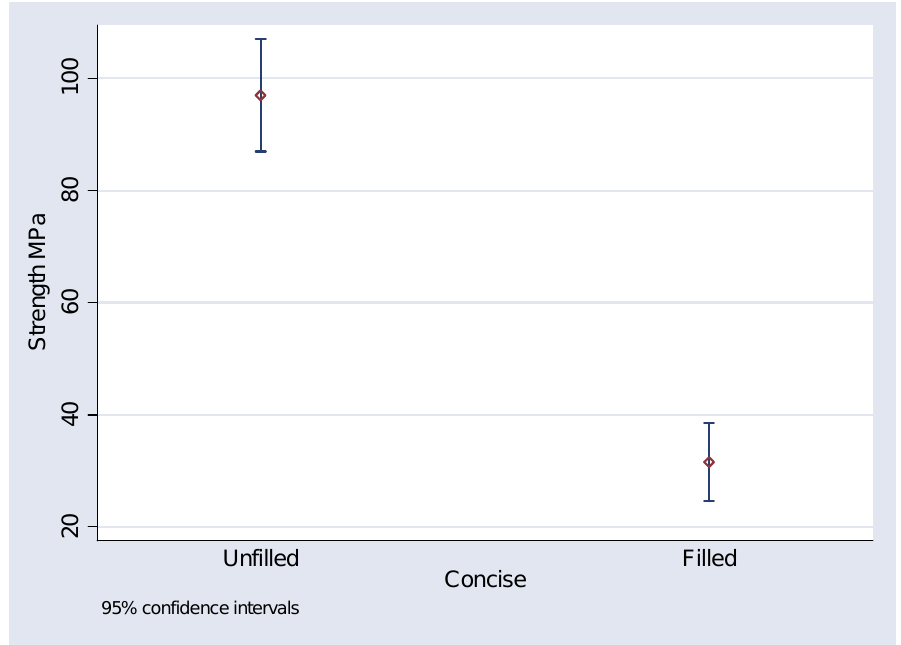
Figure 9. Means and 95% confidence intervals of the mean for Concise, unfilled and with silane coated